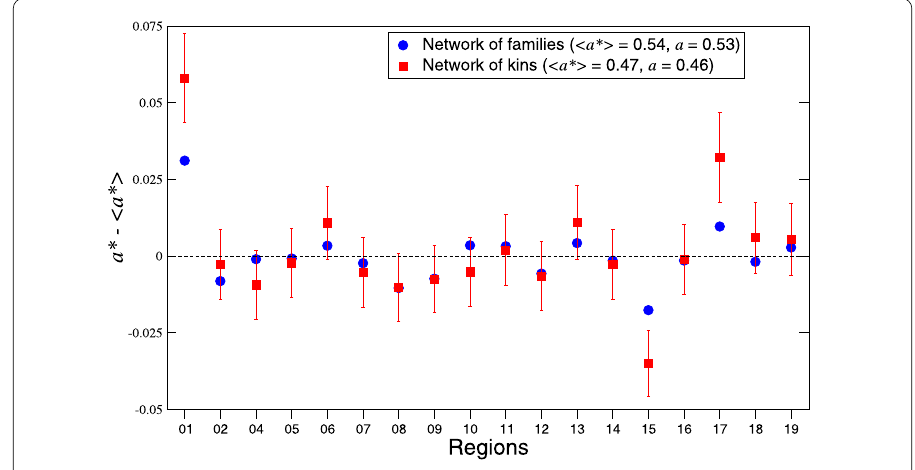
Figure 8 Assortativity coefficient. The plot shows the influence of the individual regions on the overall assortativity. For the network of families (circles) calculation is done using the region of origin of the families, and for the network of kins (squares), using the birth region of individuals. Here we estimate the influence of each region by using jackknife resampling [33]. For a given network, first the overall assortativity coefficient ( a ) is calculated using information on all the nodes (see Appendices). Then for a given region, all the nodes belonging to the region are removed, and the assortativity coefficient is recalculated ( a ∗ ). This calculation is repeated for all the regions, and the mean (cid:2) a ∗ (cid:3) is found. The difference a ∗ – (cid:2) a ∗ (cid:3) for a particular region (denoted on the horizontal axis) indicates the effect of removal of the nodes from the network. For example, a value of a ∗ – (cid:2) a ∗ (cid:3) being significantly greater than zero, indicates that the assortativity increases when the nodes are removed implying that the nodes themselves participate in disassortative mixing. For the kin network, the error bars in the quantity a ∗ are shown. For the network of families, we observe a clear correspondence of the values of a ∗ – (cid:2) a ∗ (cid:3) with the values in case of the kin network. However, the errors